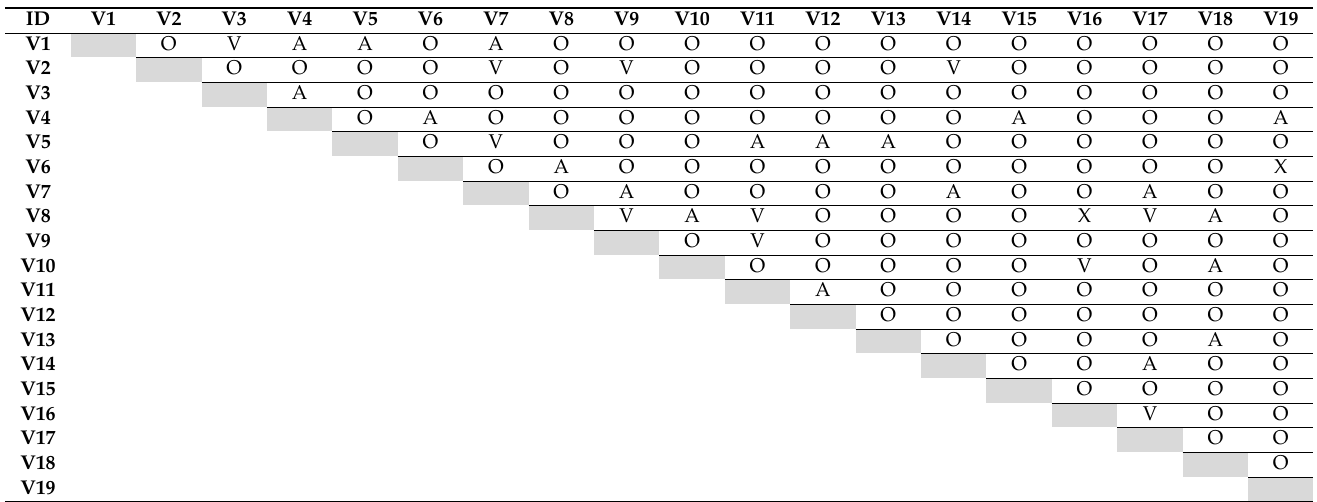
Table 1. Self-structured interaction matrix (SSIM).